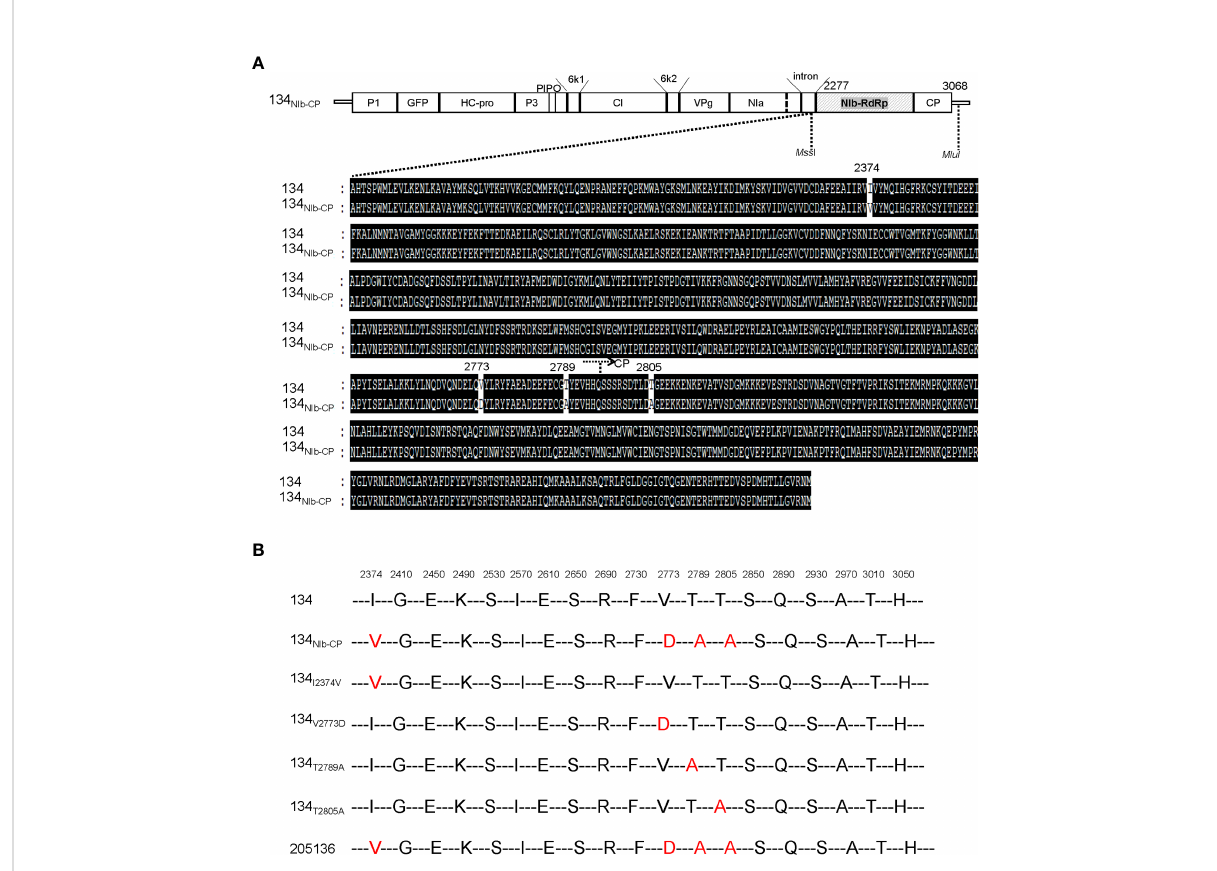
FIGURE 6 (A) Alignment of the deduced amino acid sequence of the NIb and CP of PepMoV isolates 134 and 205136. Dark highlighted amino acids are identical. Numbers are amino acid positions on the poly-protein precursor. (B) Schematic of PepMoV isolates 134-derived amino acid substitution mutants. The positions of substituted amino acids on the polyprotein precursor are indicated at the top of the amino acid